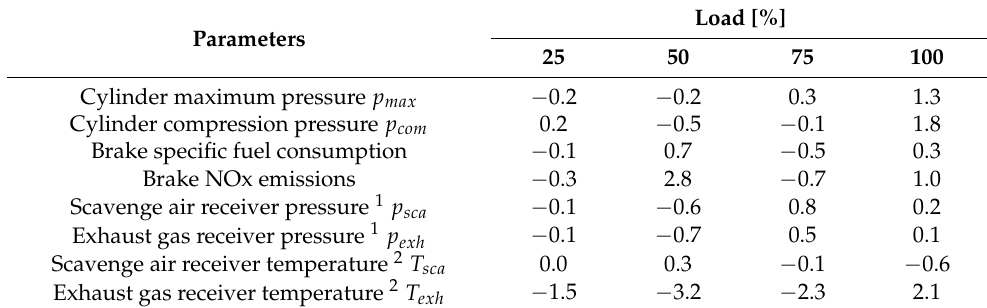
Table 5. Relative percentage errors between predicted and measured values of the engine in the Tier II mode.